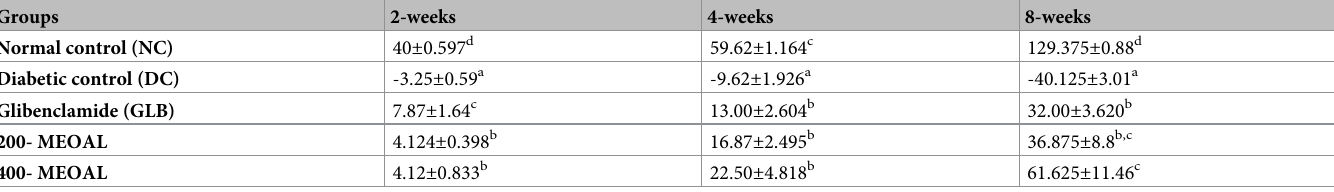
Table 4. Effects of GLB or MEOAL on the body weight gain of STZ-induced diabetic rats at different interval periods in different groups. Groups